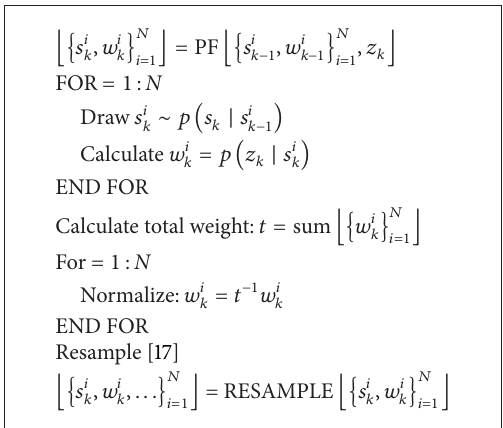
Pseudocode 1: Description of the standard particle